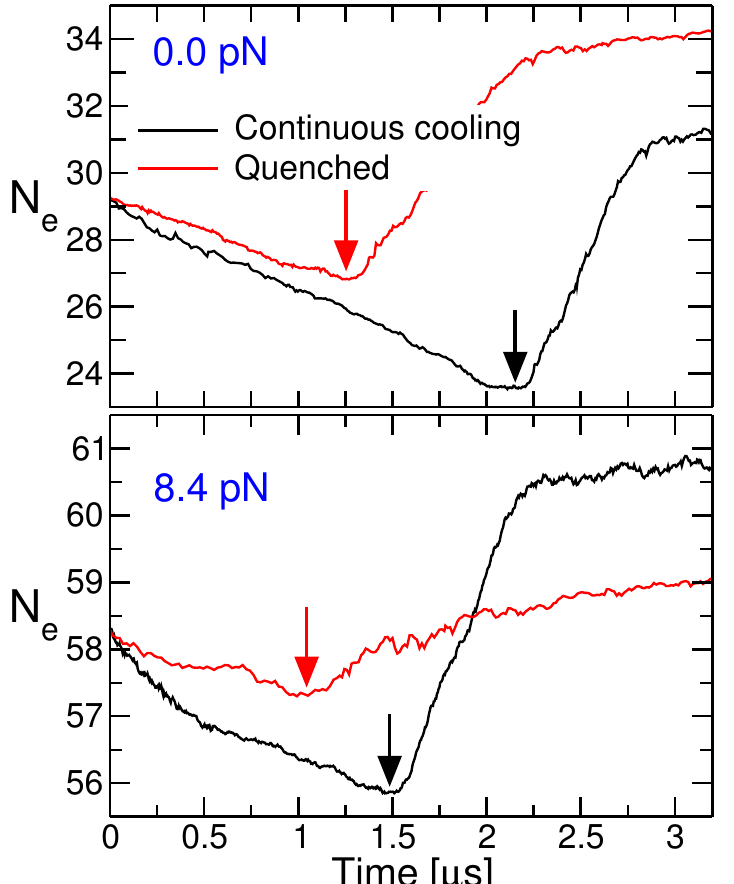
Figure 10. Change of the entanglement length during crystallization vs. time. Without force ( upper plot ) and for f = 8.4pN ( lower plot ). The arrows indicate the onset of crystallization in the under-cooled melt. Data for the quenched states are taken at 430 K.